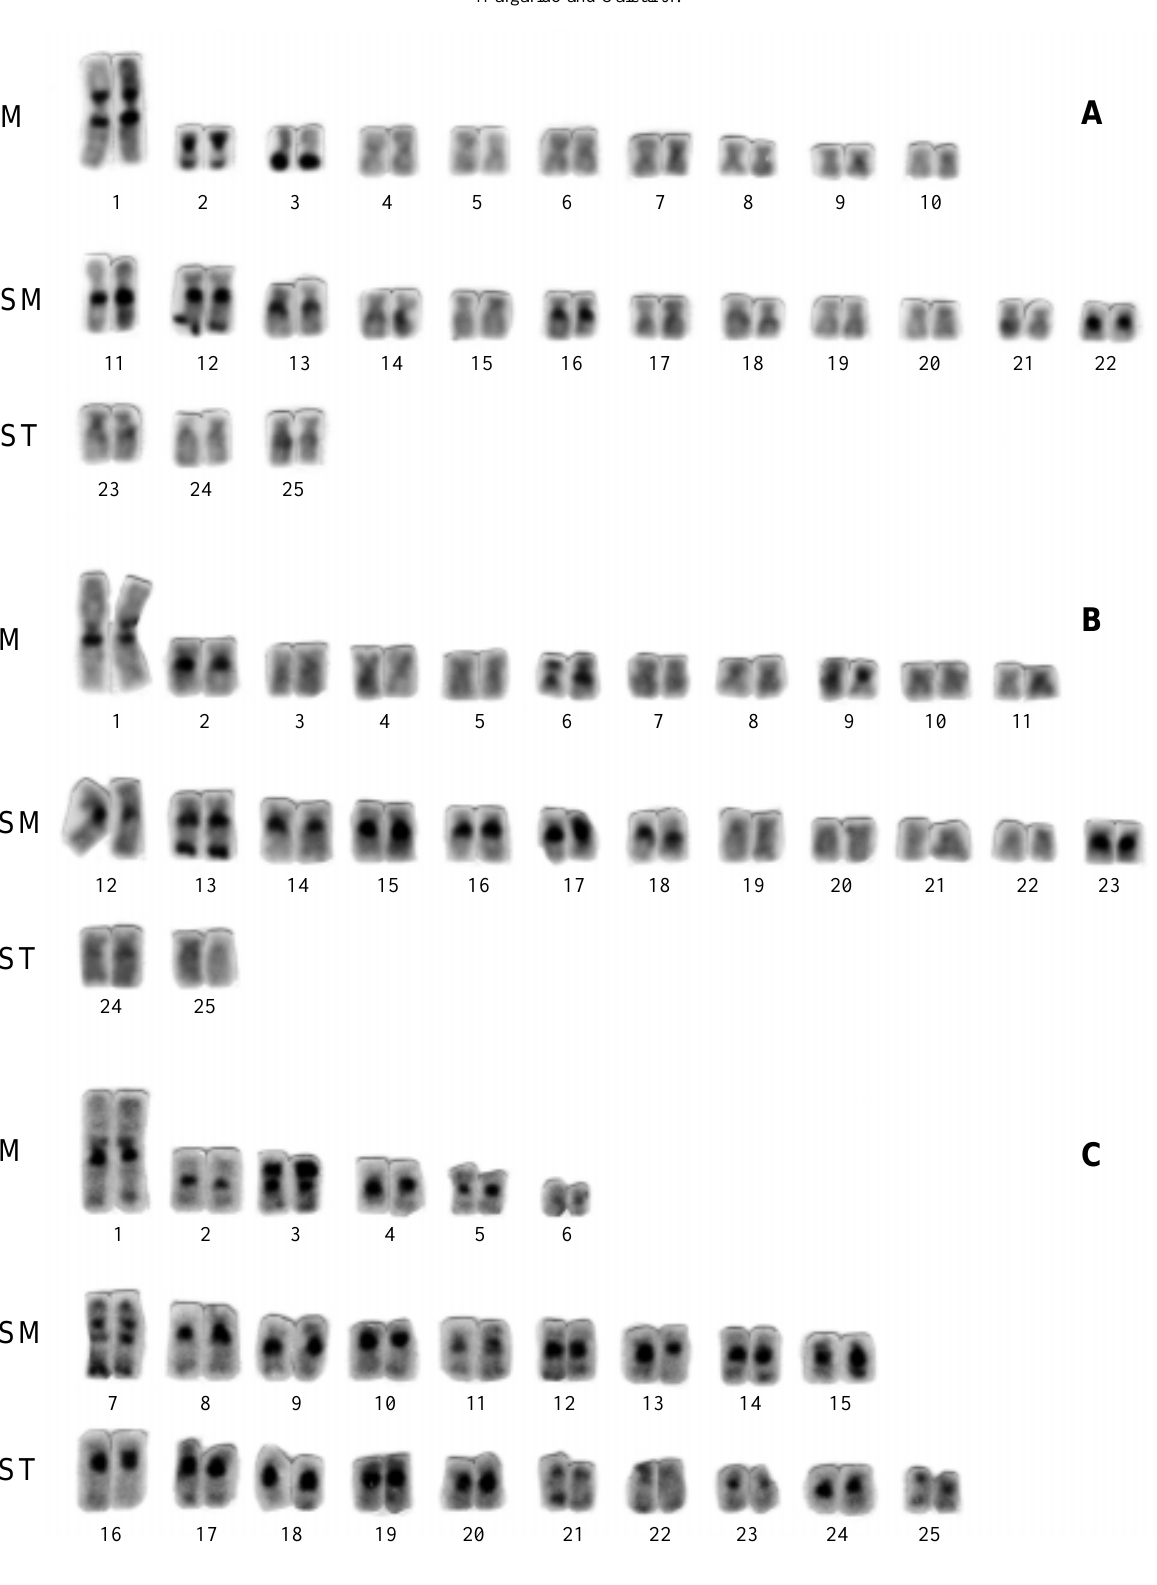
Figure 1 - C banding karyotypes of (A) Brycon microlepis , (B) Brycon lundii and (C) Salminus hilarii